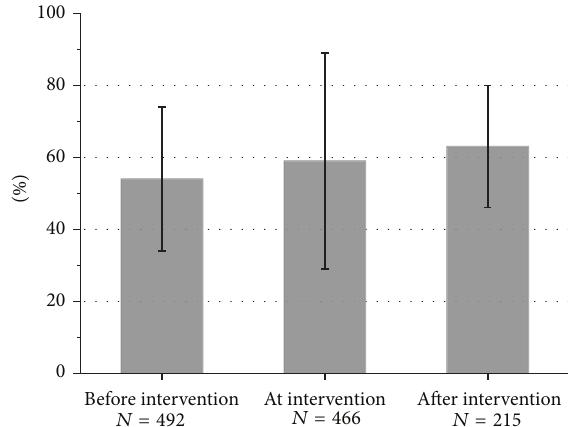
Figure 1: Average academic scores for the study cohort before, at, and after intervention. Error bars indicate one standard